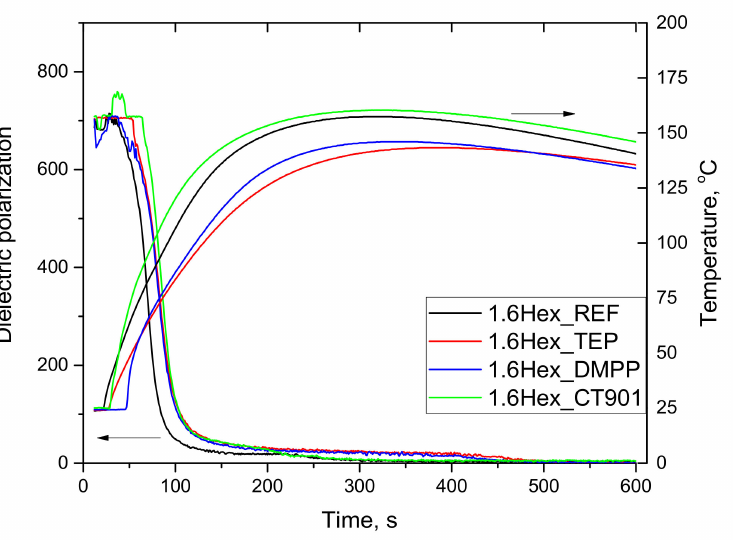
Figure 2. Influence of flame retardants addition to the reference system containing the bio-polyol on dielectric polarization and temperature during the foaming